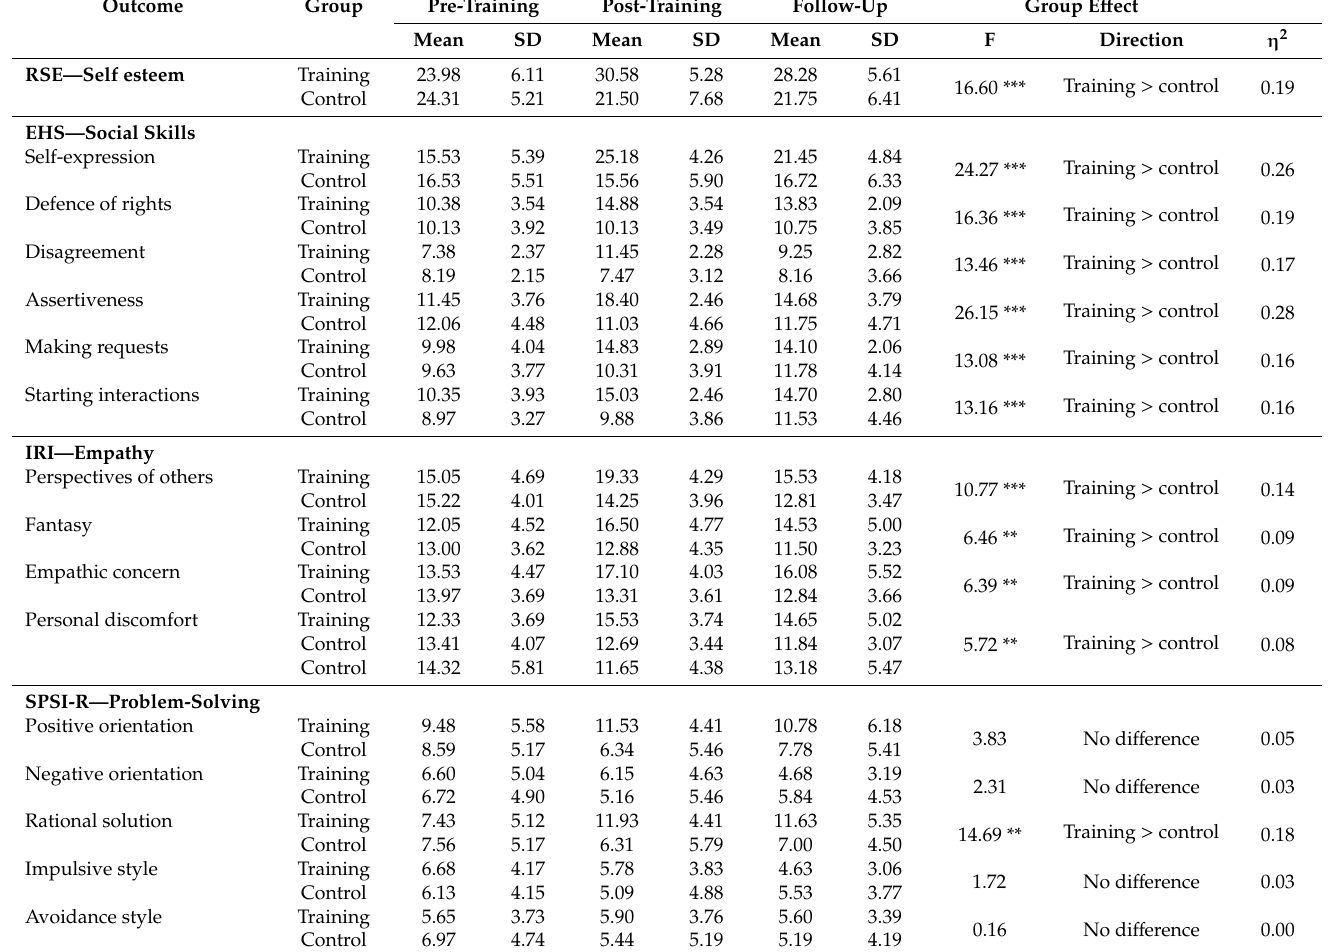
Table 2. Di ff erences between EG and CG adolescents at post-intervention and 6 month follow-up.